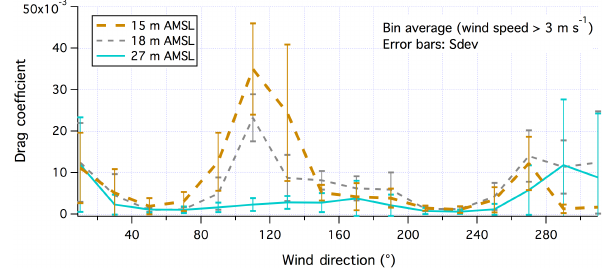
Figure 3. Drag coefficient vs. true wind direction at three sampling heights. Lines represent averages (wind speed > 3ms − 1 only) and the error bars indicate standard deviations within each wind direc- tion bin. Wind data are from the Windmaster Pro sonic anemometer.